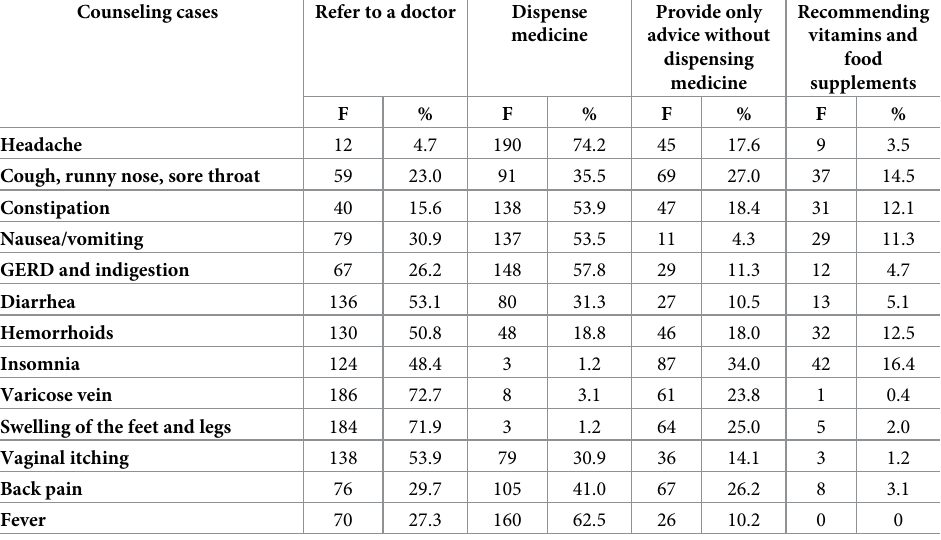
Table 1. Number and percentage of the questions on CPs knowledge about OTC medications and counseling dur- ing pregnancy (n = 256). Counseling cases